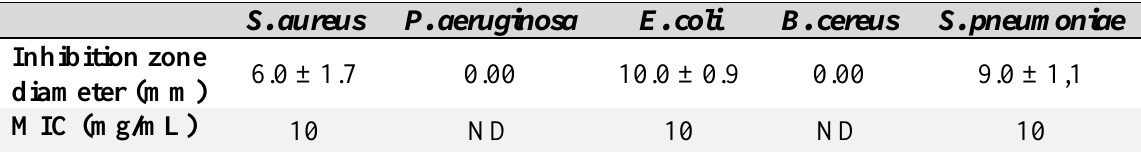
Table 3. Antibacterial activity of the hydromethanolic extract of Adiantum